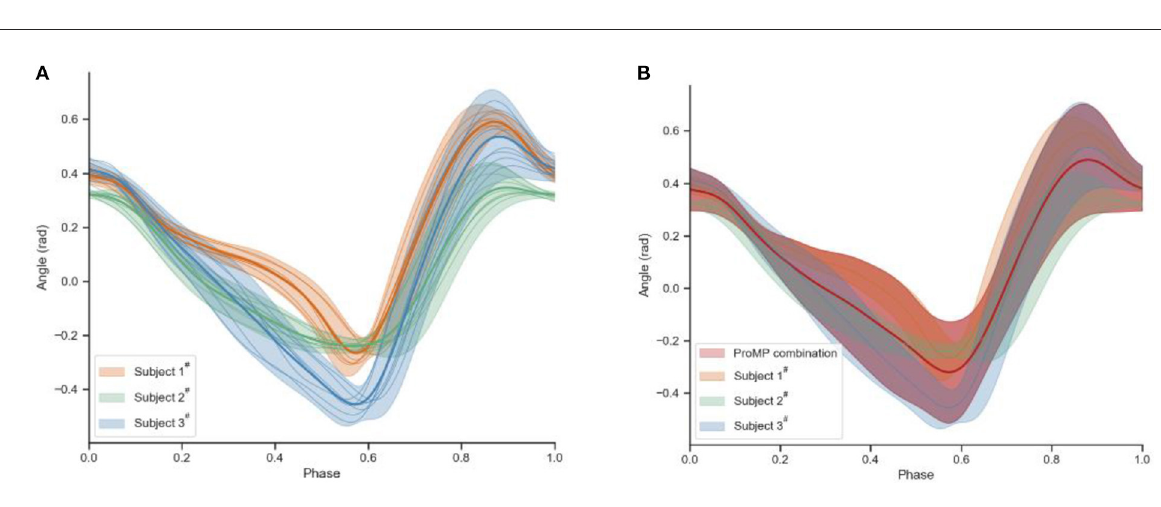
target dotted blue one. Therefore, the basis function of ProMPs is adopted